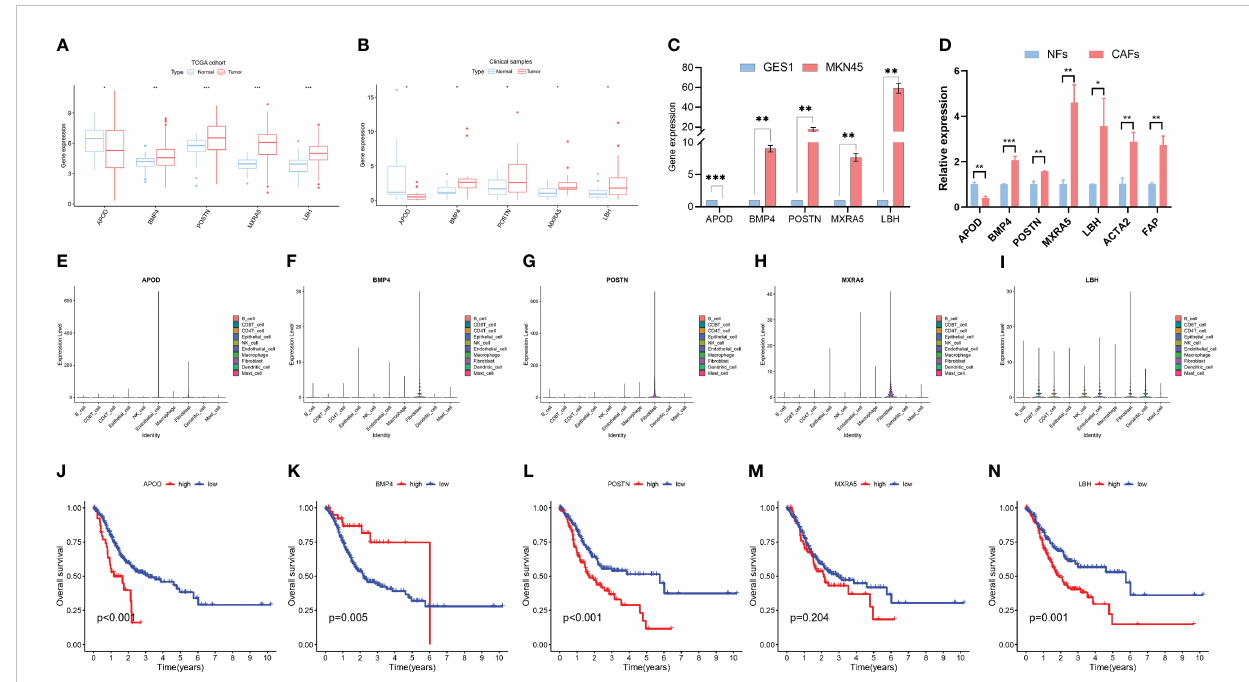
FIGURE 4 Characteristics of 5 hypoxia-related genes in gastric cancer. (A) Expression differences of 5 hypoxia-related genes in normal and gastric cancer tissues in the TCGA dataset. (B) Validation of the expression of 5 hub genes by PCR in clinical patients. (C) Validation of the expression of 5 hub genes by PCR in cell lines. (D) Validation of the expression of 5 hub genes by PCR in NFs and CAFs. (E – I) . The expressions of 5 hub genes in different cells according to scRNA-seq data. (J – N) . Kaplan − Meier analysis of patients in high- and low- expression groups of these 5 hub genes. * means p<0.05; ** means p<0.01; *** means